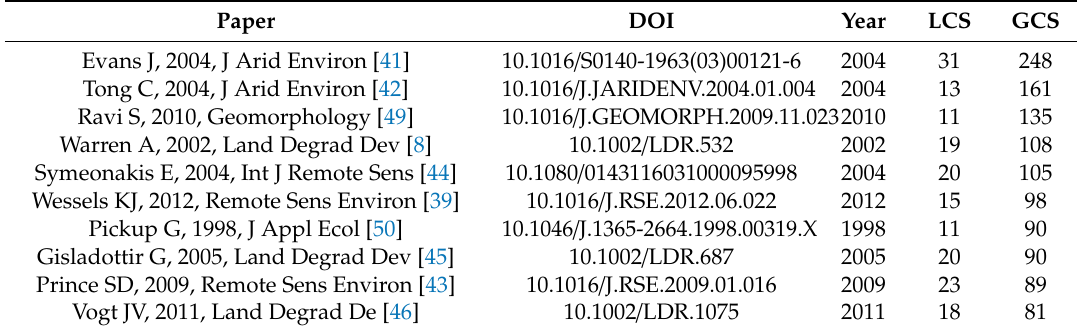
Table 2. Top 10 global citation scores (GCS) in land degradation